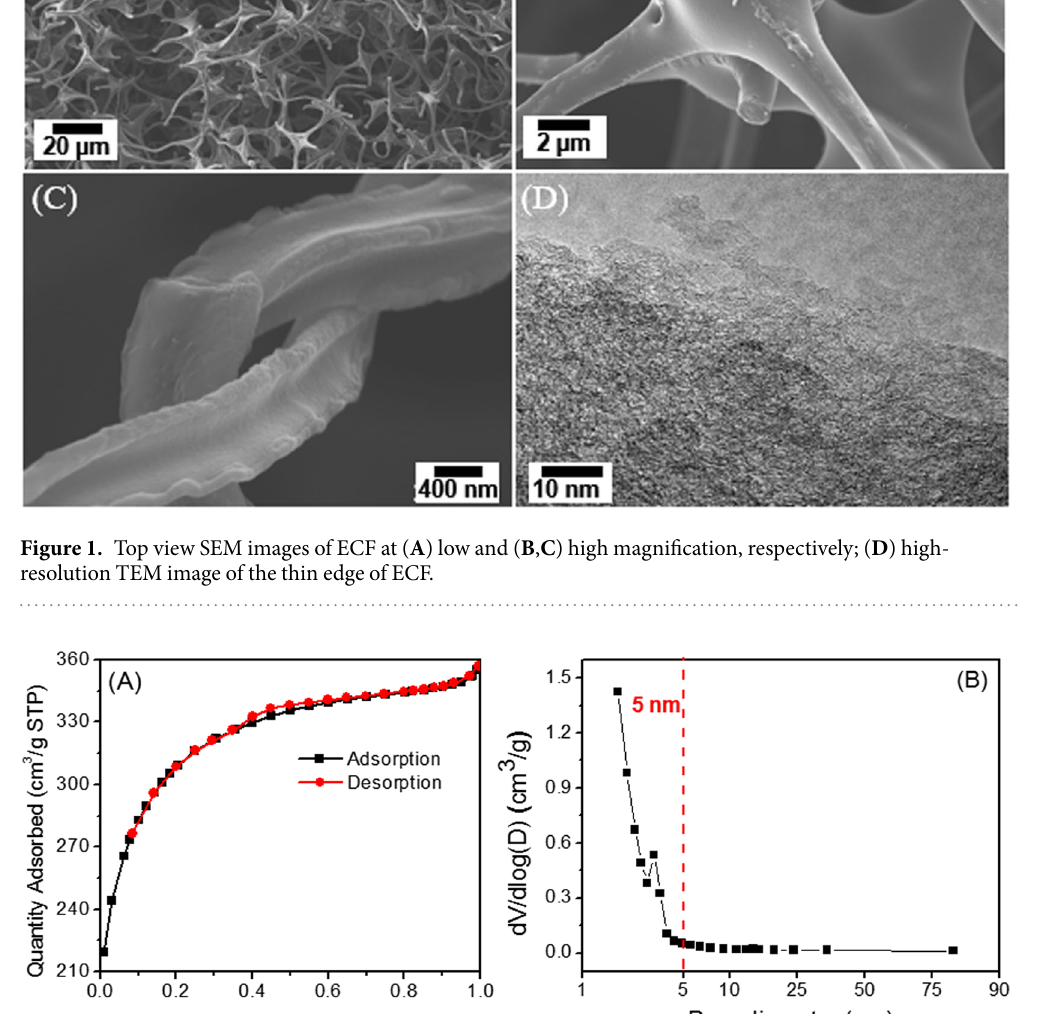
pore size distribution plot is shown in Fig. 2(B). The analysis of the N 2 adsorption data further demonstrated the presence of mesopores ranging from ~2 to 5 nm as well as micropores less than ~2 nm with a total pore volume of 0.55 cm 3 /g. As calculated, the micropore and mesopore ( > 2 nm) volumes are 0.25 and 0.30 cm 3 /g, respectively. The distribution of pore sizes corresponds to the observation from TEM images (Fig. 1D). Raman spectroscopy and X-ray diffraction (XRD) are two techniques that can be used to characterize carbon allotropes. Although all the carbon materials are formed upon C-C bonds, the orientation of C-C bonds alters from one structure to the other. Since graphite is well known Li ion battery electrode material, the Raman and XRD characterizations of the carbon foam were analysed using graphite as the reference. Raman characteristic peaks of sp 2 hybridized C = C bonds in graphite known as D1, D2 and G band, normally occur at 1350,1362 and 1580 cm − 1 , respectively. D-bands correspond to the surficial defects or edge planes while G-band represents the interior of the perfect crystalline structure in which G-bands normally have higher intensity of Raman scattering than that of D-bands 21 . As shown in Fig. 3(A), the Raman peaks of ECF at ~1320 and ~1600 cm − 1 indicate the shifted D and G bands, respectively. The higher surface area of carbon foam compared to graphite attributed to the presence of more dangling bonds and more intrinsically light scattering behaviour of the edges. The peak shift from 1350–1360 cm − 1 in graphite to 1320 cm − 1 in carbon foam illustrates the mechanical or thermal effects